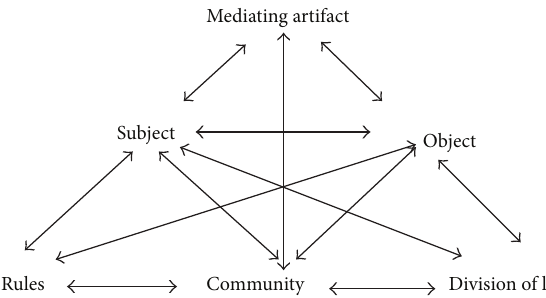
Figure 1: Components of the CHAT system [22, page